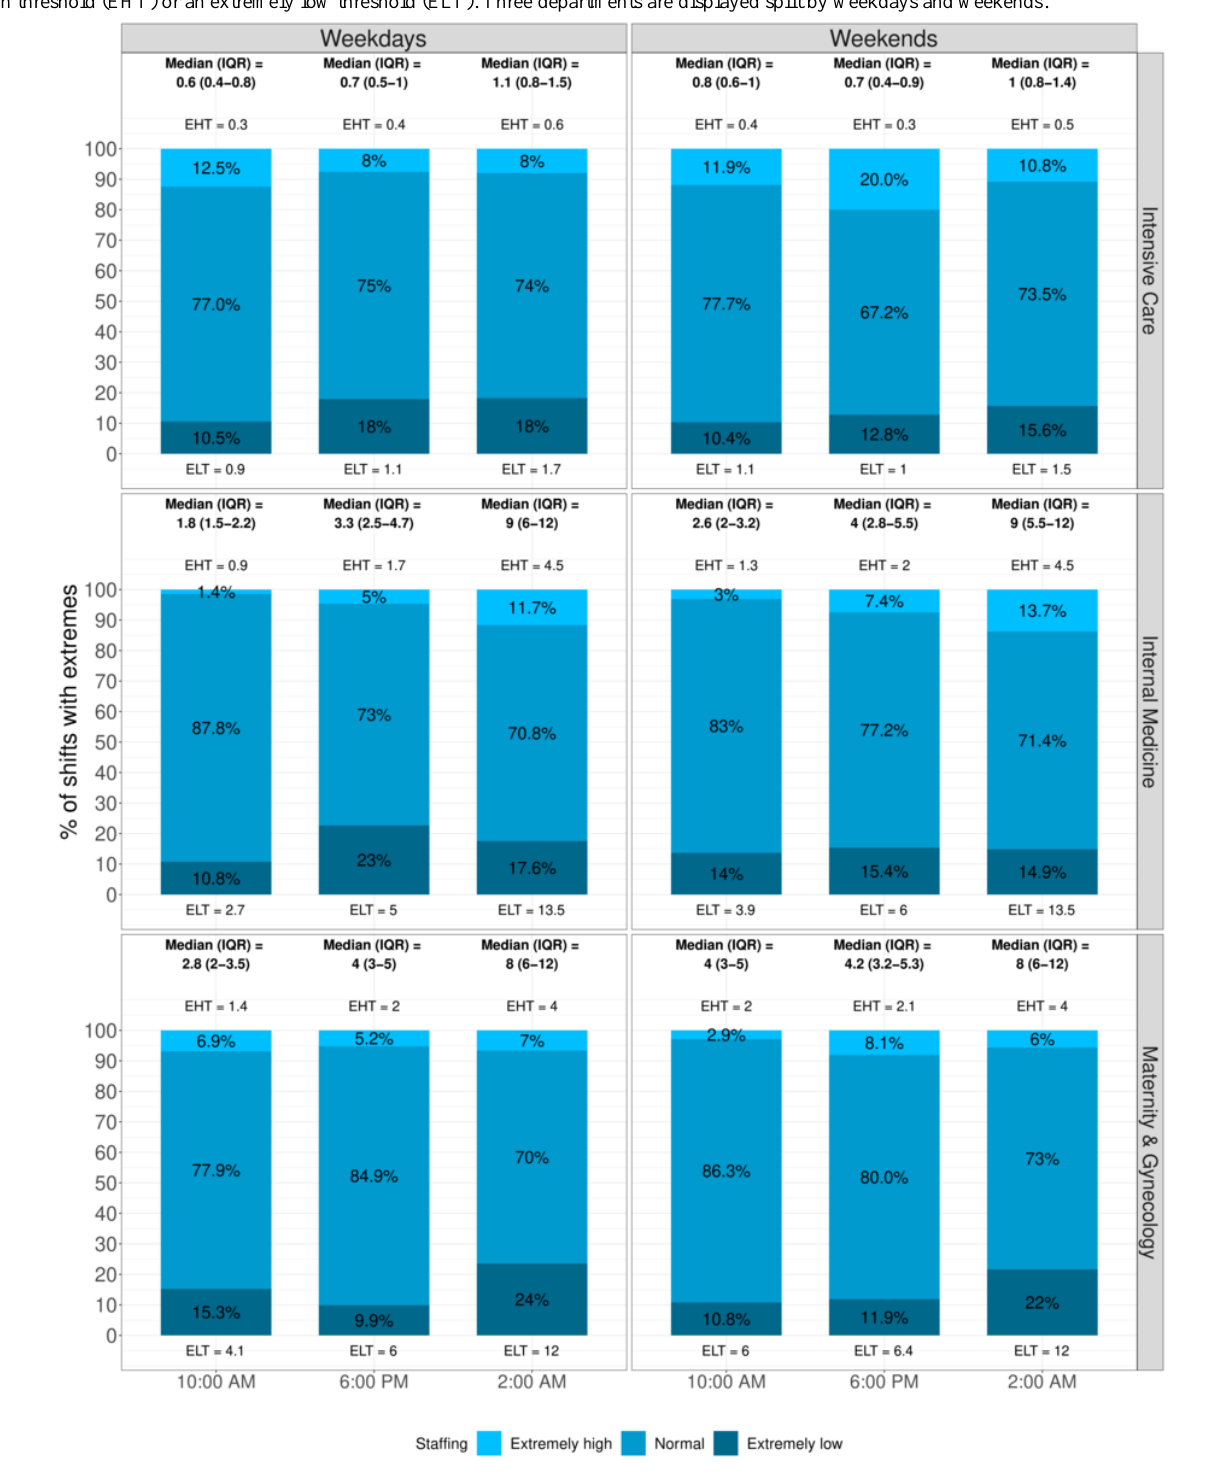
Figure 3. Median (interquartile range [IQR]) patient-to-registered nurse ratios for key time points, with the percentages of shifts with an extremely high threshold (EHT) or an extremely low threshold (ELT). Three departments are displayed split by weekdays and